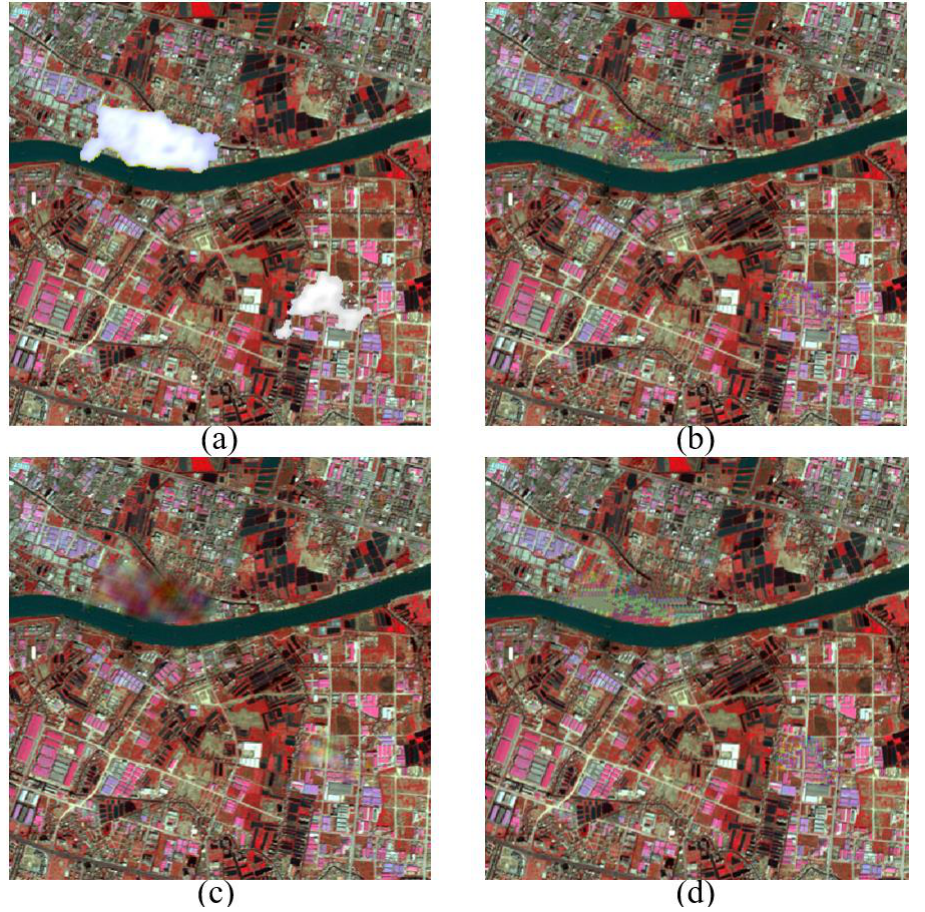
Figure 7. Comparison of Clouds Removal from SPOT5 Multispectral Imagery. ( a ) SPOT5 Image (displayed as false color composites) with Preprocessed Clouds; ( b ) Cloud Removal by Our Inpainting Method; ( c ) Cloud Removal by MCA [46]; ( d ) Cloud Removal by [26].